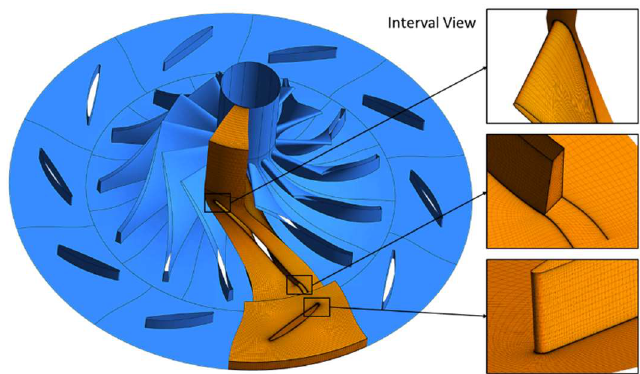
Figure 1. Physical model and computational domain